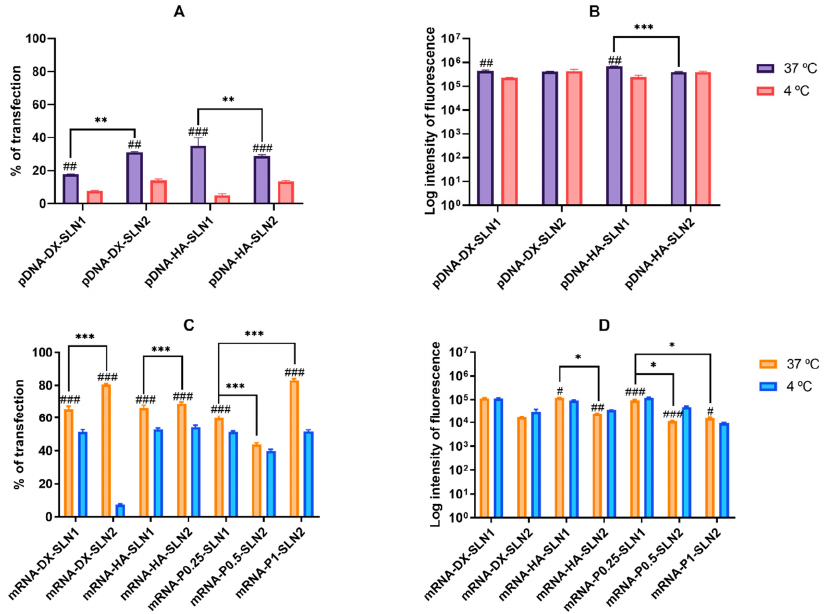
Figure 3. Percentage of transfected cells and intensity of fluorescence of ARPE-19 cells after incubation with SLN1- and SLN2-based vectors at 37 and 4 ◦ C. Data are expressed as mean ± standard deviation; n = 3. ( A ) Percentage of transfected ARPE-19 cells 72 h after treatment with pDNA vectors. ( B ) Intensity of fluorescence of transfected ARPE-19 cells 72 h after treatment with pDNA vectors. ( C ) Percentage of transfected ARPE-19 cells 48 h after treatment with mRNA vectors. ( D ) Intensity of fluorescence of transfected ARPE-19 cells 48 h after treatment with mRNA vectors. # p < 0.05 with respect to the same vector at 4 °C. ## p < 0.01 with respect to the same vector at 4 °C. ### p < 0.001 with respect to the same vector at 4 °C. * p < 0.05 with respect to the other formulation. ** p < 0.01 with respect to the other formulation. *** p < 0.001 with respect to the other formulation.